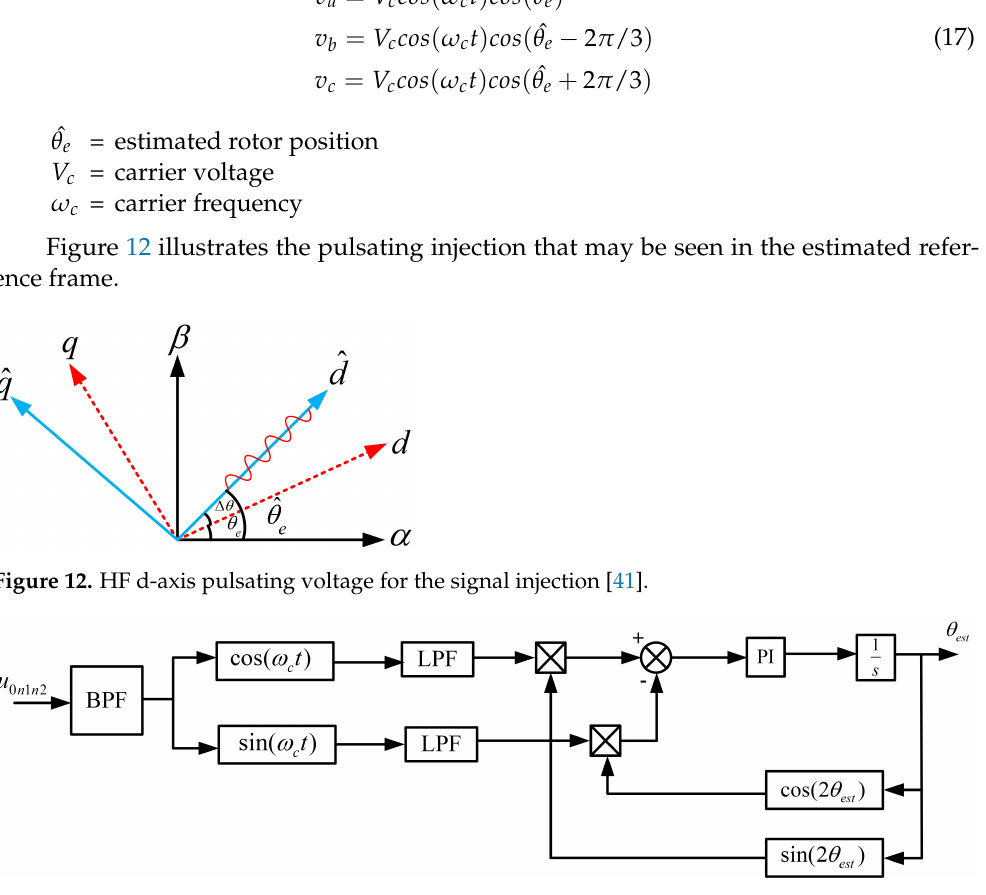
Figure 13. Block diagram of zero-sequence carrier signal process with rotating injection